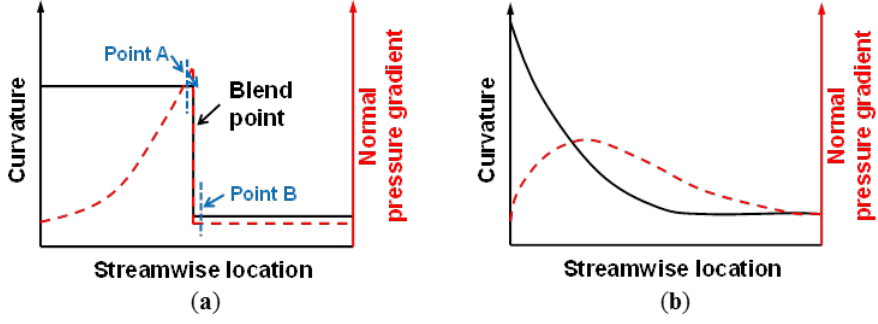
Figure 28. Schematic streamwise variation of curvature and normal pressure gradient at zero effective incidence: ( a ) Circular LE; ( b ) Continuous-curvature